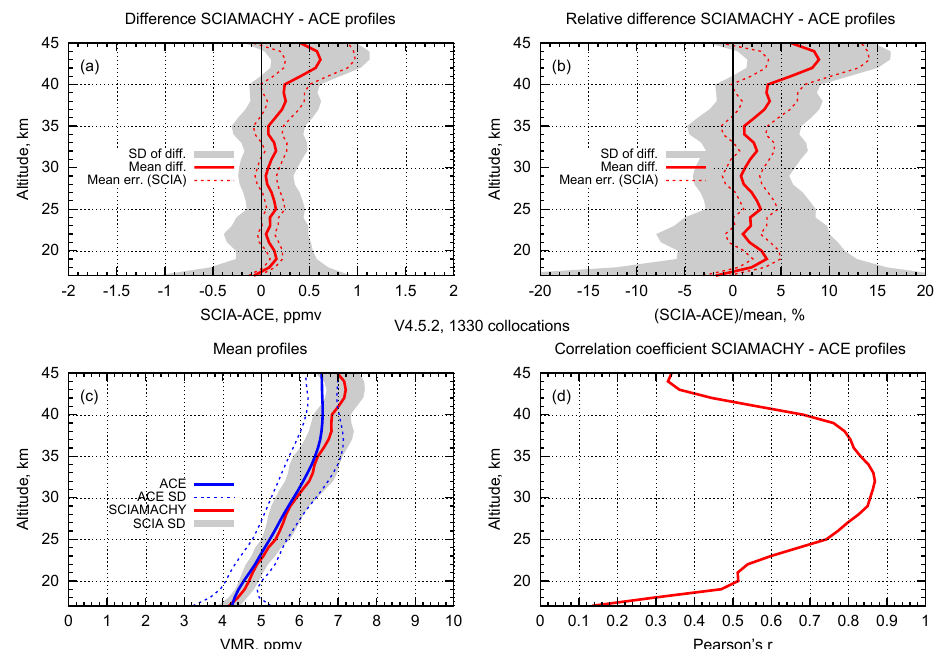
Figure 4. Comparison of retrieved SCIAMACHY H 2 O profiles with ACE-FTS data 2004–2012. (a) Mean difference plus/minus one standard deviation (SD) (shaded area) and mean error of SCIAMACHY data (dotted line). (b) Mean relative difference plus/minus one standard devia- tion (shaded area) and mean relative error of SCIAMACHY data (dotted line). (c) Mean profiles and standard deviations (red: SCIAMACHY, blue: ACE-FTS). (d) Correlation between SCIAMACHY and ACE-FTS data.